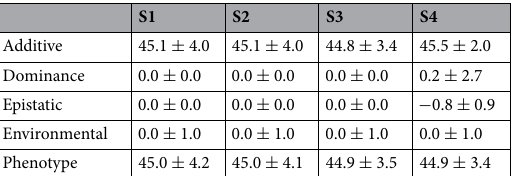
Table 1. Breakdown of phenotype of 369 lines in the initial population under four simulators.